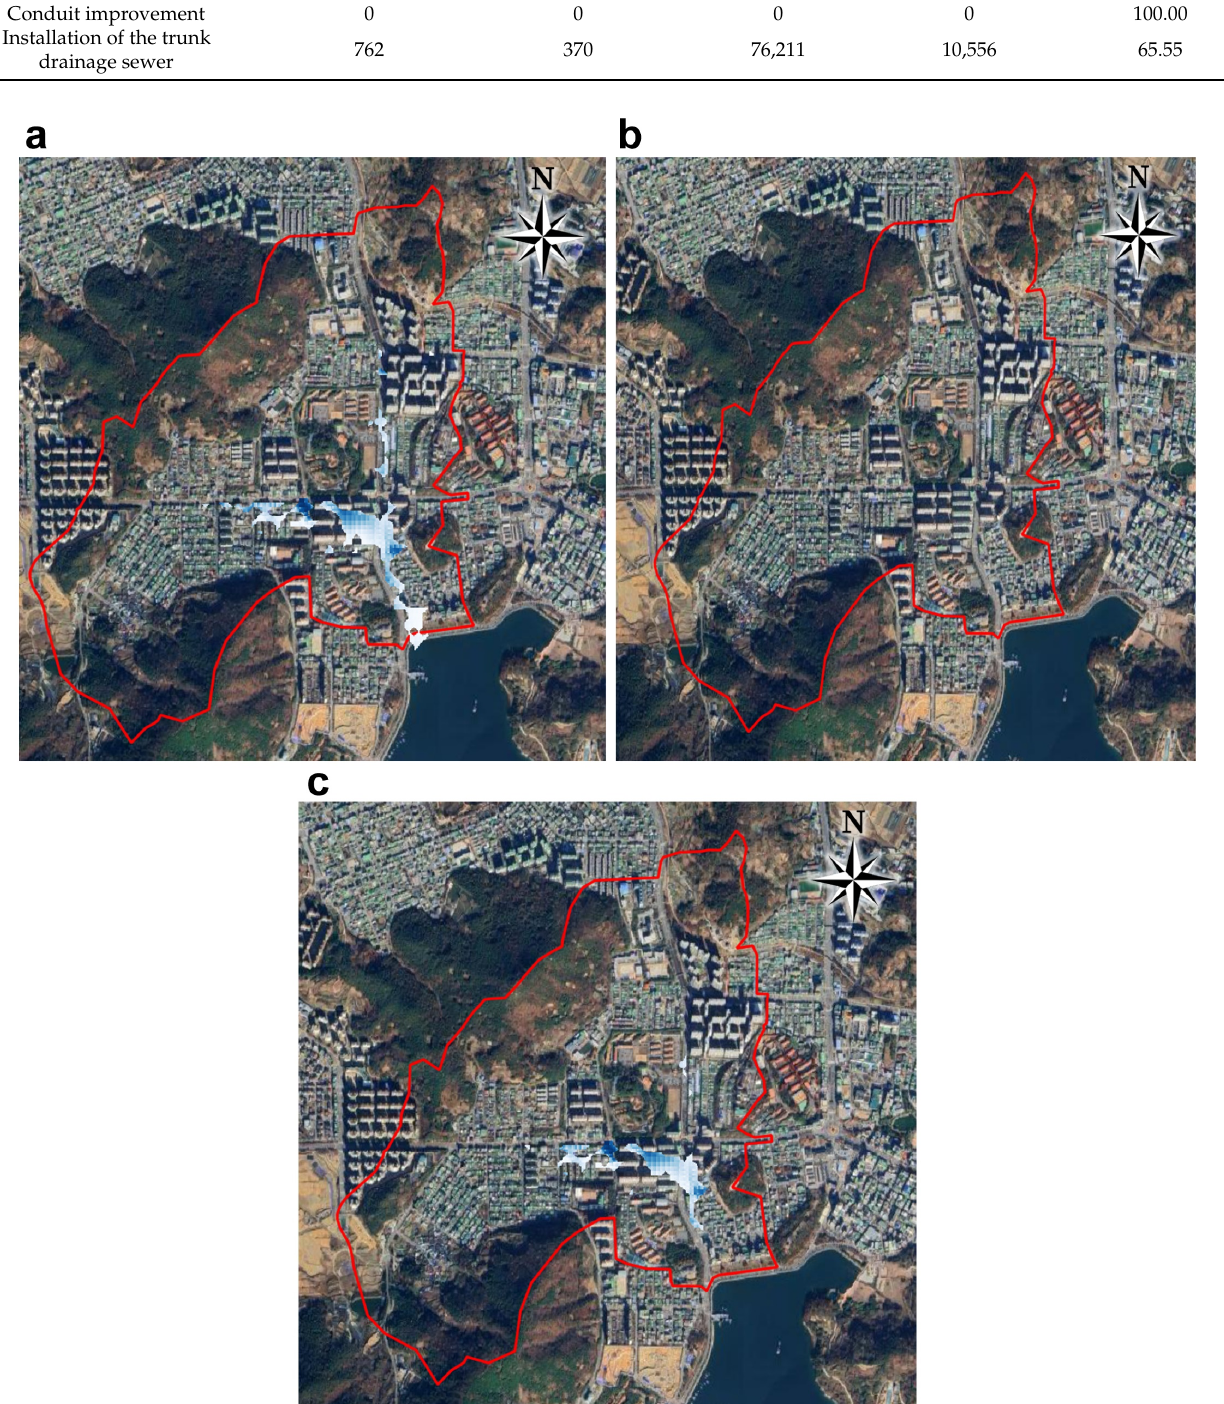
Figure 16. Flood analysis in the Dowon watershed according to the flood damage reduction facility installation conditions. ( a ) Not installed, ( b ) conduit improvement, and ( c ) installation for the trunk drainage system.